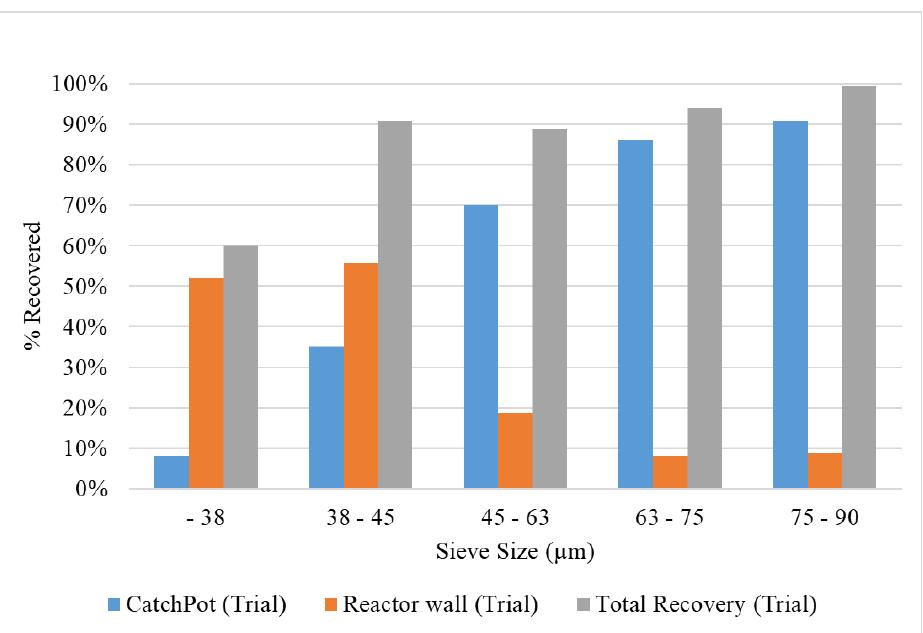
Figure 2. Product distribution for fractions after plasma treatment of control trial sample.